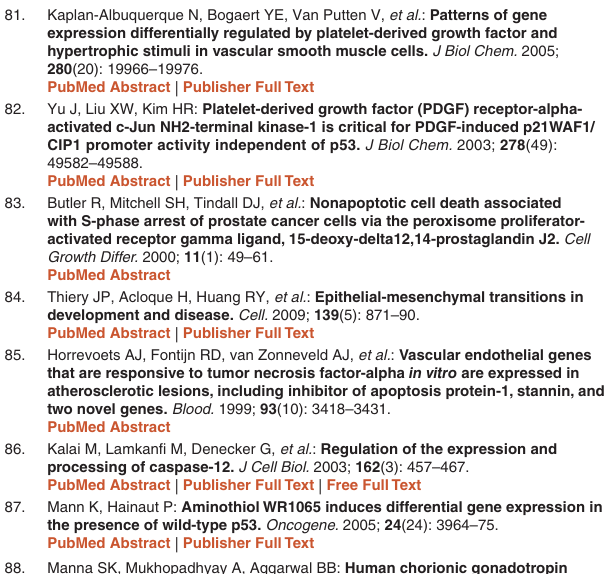
Figshare. 2014. Data